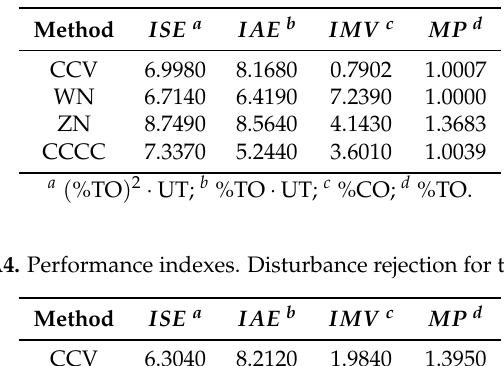
Table A3. Performance indexes. Set-point tracking for the set P 1 .